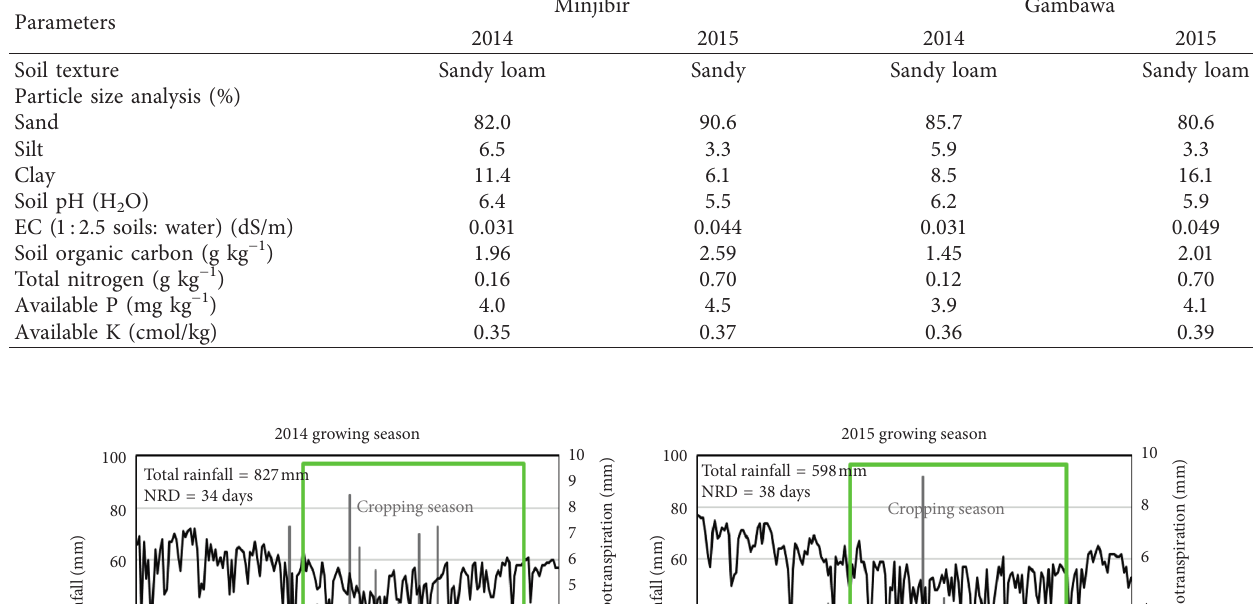
Table 1: Analysis of physical and chemical properties of the soils (0–20cm depth) at Minjibir and Gambawa. Parameters